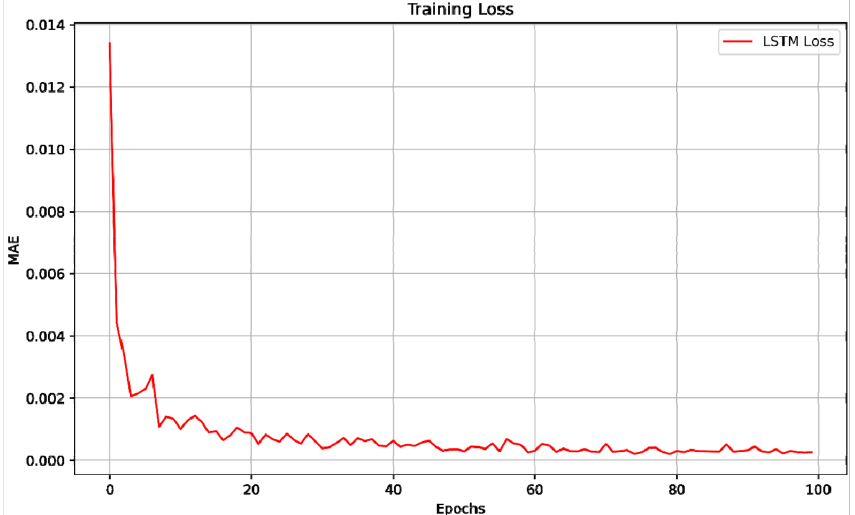
Figure 22. Relationship between loss and epochs using